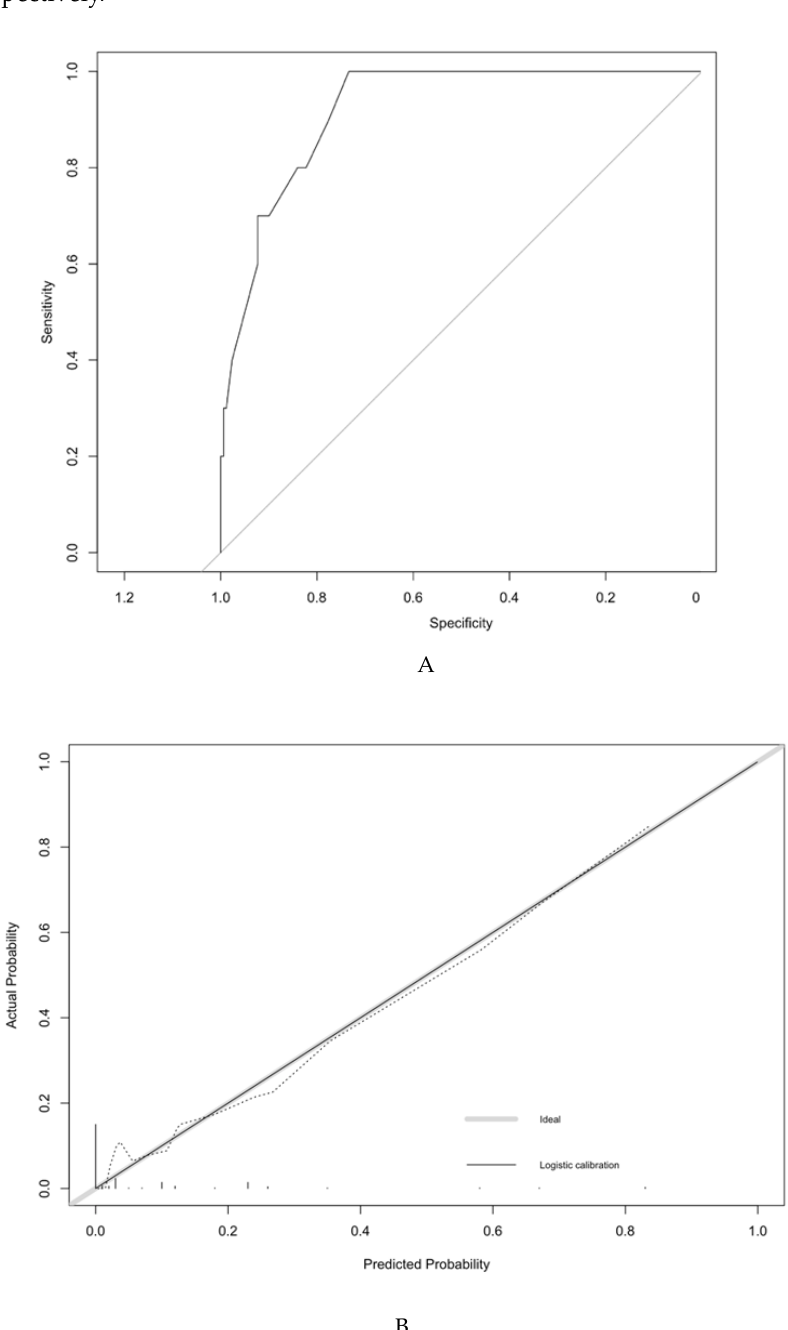
Figure 3. Discrimination and validation of the model predicting the likelihood of a parametrial involvement in patients with early stage cervical cancer. ROC curve of the model. The predictive model had an AUC of 0.92 (IC95% = 0.86–0.98). For the calibration of the model, the horizontal axis represents the predicted probability of a parametrial involvement, and the vertical axis represents the actual probability of parametrial invasion. Perfect prediction would correspond to the 45-degree broken line. The dotted and solid lines indicate the observed (apparent) nomogram performance before and after bootstrapping.